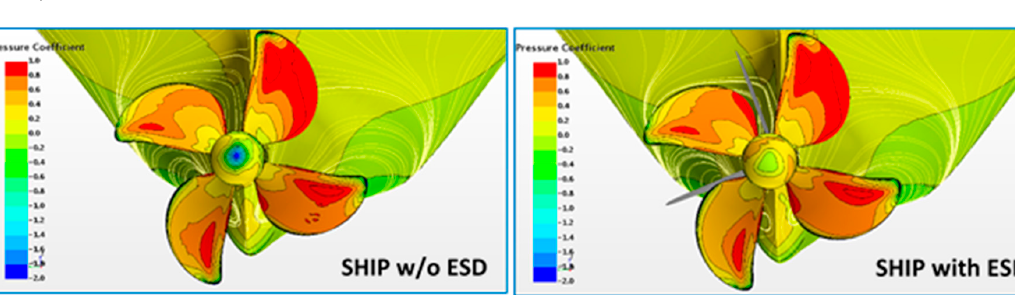
Figure 12. Pressure distribution and flow streamlines past the aft ship. (PSS-Var-5, full scale, Vs = 14 kn).